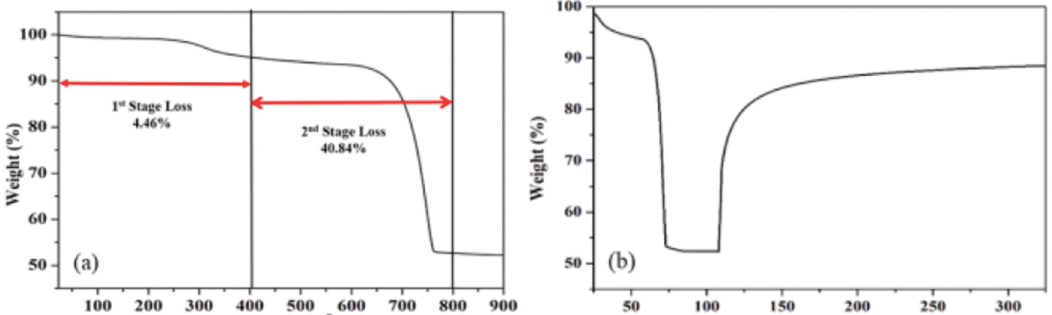
Figure 6: ( a ) TGA of fresh ESs and ( b ) carbonation test for the detection of the actual CaO fraction [ 99 ]